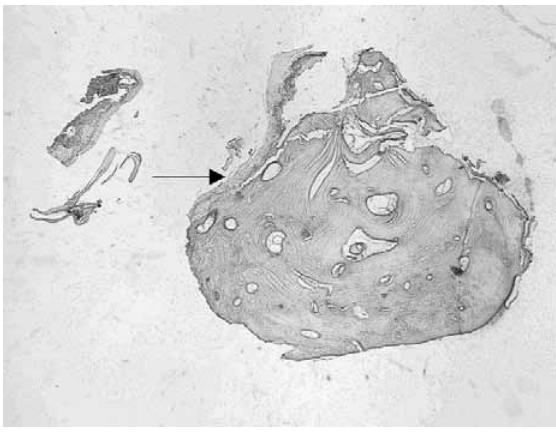
Figure 1. Histological cross-section of malleus head after mechanical treatment (decaltification, haematoxylin and eosin staining, magnification 100 x). The black arrowhead points to the residual squamous cell epithelium after